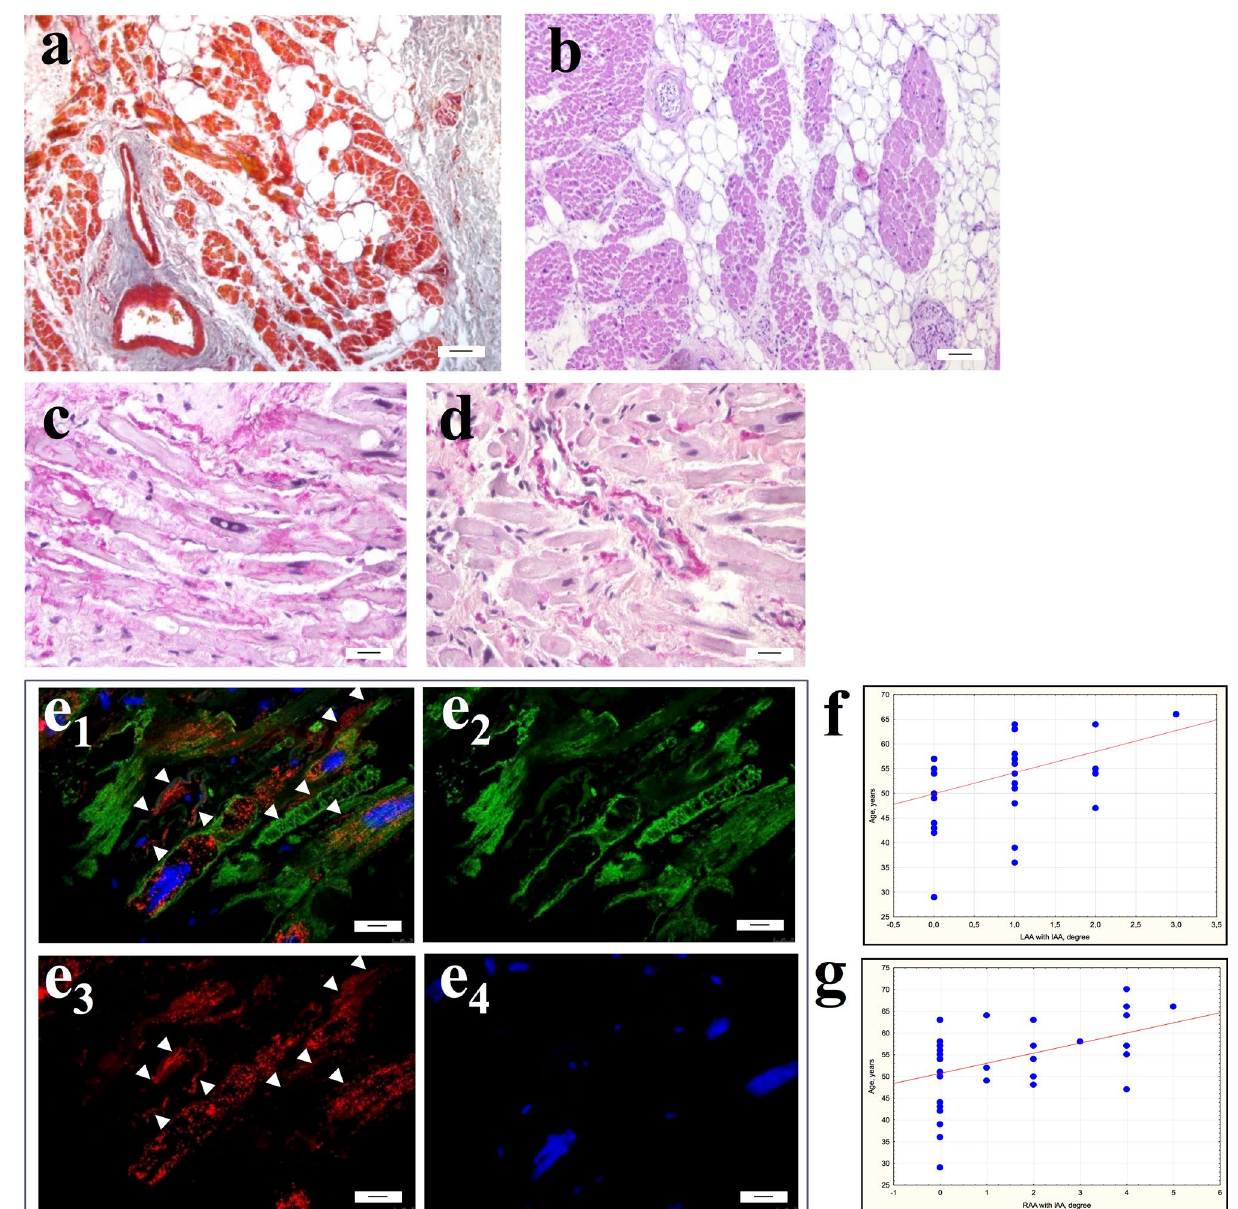
Figure 1. Interstitial area of atrial appendage myocardium of patients with AF. ( a , b ) Significant fibrosis and lipomatosis in the interstitium of atrial appendage myocardium. ( a ) Masson’s trichrome stain. ( b ) Hematoxylin and eosin. bar 7 µm. ( c–e ) Isolated atrial amyloidosis in atrial appendage myocardium. Amyloid deposition in the interstitial area on the surface of cardiomyocytes ( c ) and the wall of the intramural vessel ( d ). ( c , d ) Sirius red stain. bar 30 µm. e 1-4 —ANP + fibrillar material in the interstitium on the surface of cardiomyocytes sarcolemma and in the walls of blood vessels (arrows). ANP + atrial granules in the sarcoplasm of cardiomyocytes. e 1 —ANP/ Desmin/DAPI immunohistochemistry. e 2 —Desmin-positive fibrils in the sarcoplasm of cardiomyocytes (Alexa 488). e 3 —Detection of ANP-positive atrial granules in the sarcoplasm of cardiomyocytes and ANP-positive fibrils in the interstitium (arrows) (Alexa 546). e 4 —DAPI-stained nuclei. Immunoconfocal laser microscopy. bar 10 µm. (f , g ) Correlation of the amyloid distribution in the LAA ( f ) and RAA ( g ) myocardium with the age of patients with